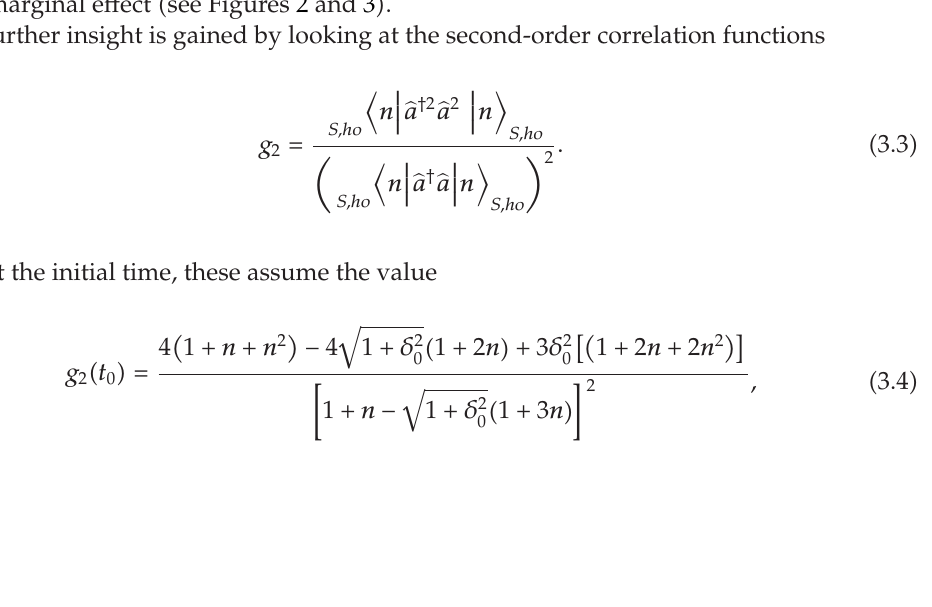
(cid:20) t ω (cid:5)(cid:8)(cid:4) 0.1,0 (cid:5) ; (cid:4) b (cid:5) | 0 (cid:4) for (cid:4) ω, (cid:20) t 0 t ω (cid:5)(cid:8)(cid:4) 2.5,1.5 (cid:5) . δ 0 (cid:8) 1 . 7 in all figures. t 0